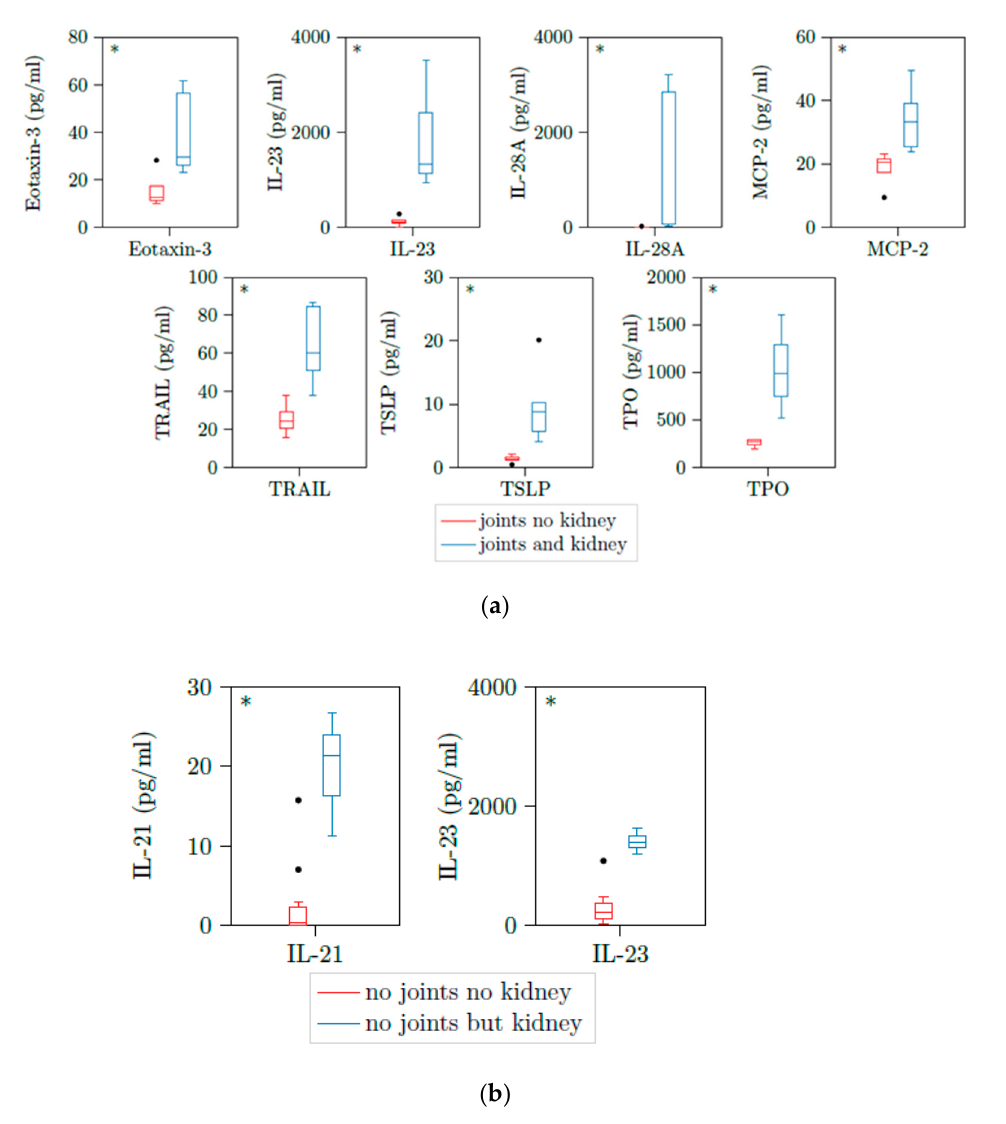
Figure 4. ( a ) Eotaxin-3, IL-23, IL-28A, MCP2, TRAIL, TSLP, and TPO are upregulated in patients with active AAV with both joint involvement and kidney involvement. Illustration of Eotaxin3, IL-23, IL-28A, MCP2, TRAIL, TSLP, and TPO plasma concentrations of 13 samples with active PR3-AAV and joint involvement. All cytokines were significantly elevated in patients with additional kidney involvement versus those without kidney involvement. * p < 0.05; boxes and whisker plots present distribution of the median, the upper and lower quartile, the whiskers with 1.5 of the interquartile distances, as well as the outliers. ( b ) IL-21 and IL-23 are upregulated in patients with active AAV with no joint involvement but kidney involvement. Illustration of IL-21 and IL-23 plasma concentrations of 9 samples with active PR3-AAV and joint involvement. All cytokines were significantly elevated in patients with additional kidney involvement versus those without kidney involvement. * p < 0.05; boxes and whisker plots present distribution of the median, the upper and lower quartile, the whiskers with 1.5 of the interquartile distances, as well as the outliers.